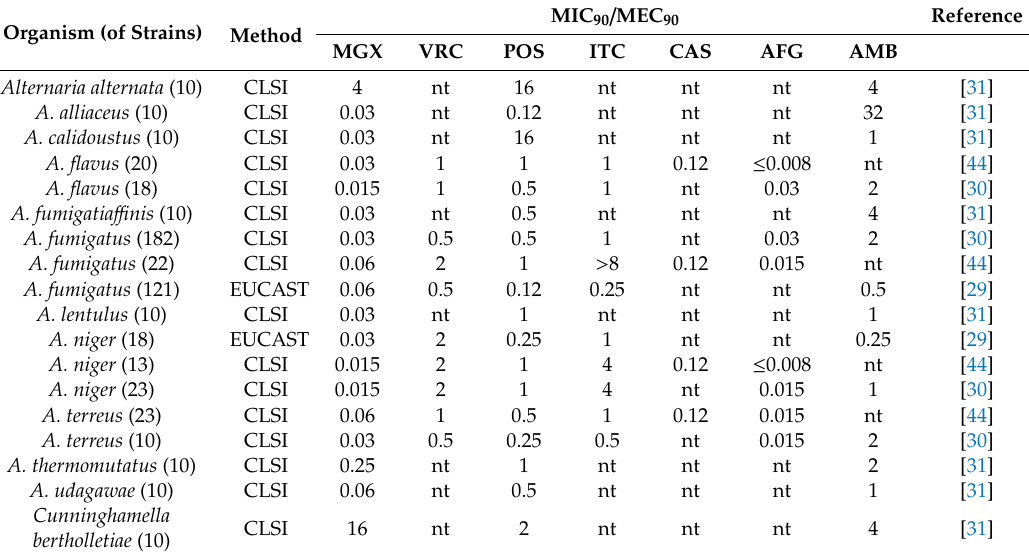
Table 3. Summary of the in vitro activity of MGX against